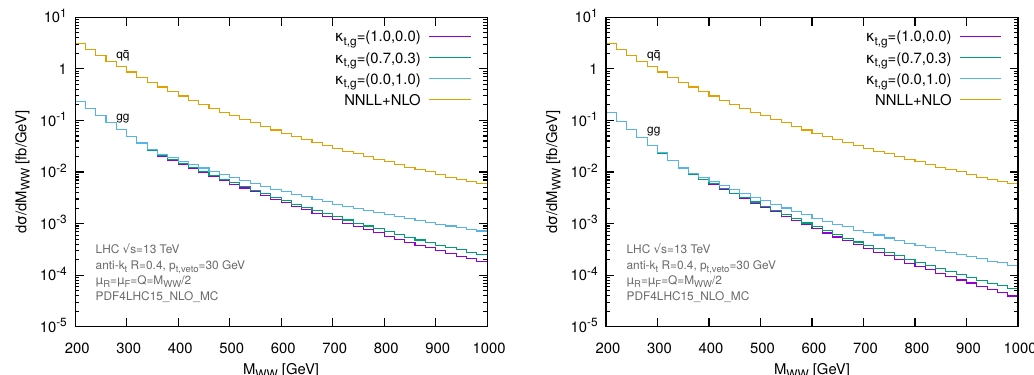
Figure 3 . The di(cid:11)erential cross section d(cid:27)=dM WW for the three benchmark scenarios of eq. (4.3), at LO (left) and at NLL (right)